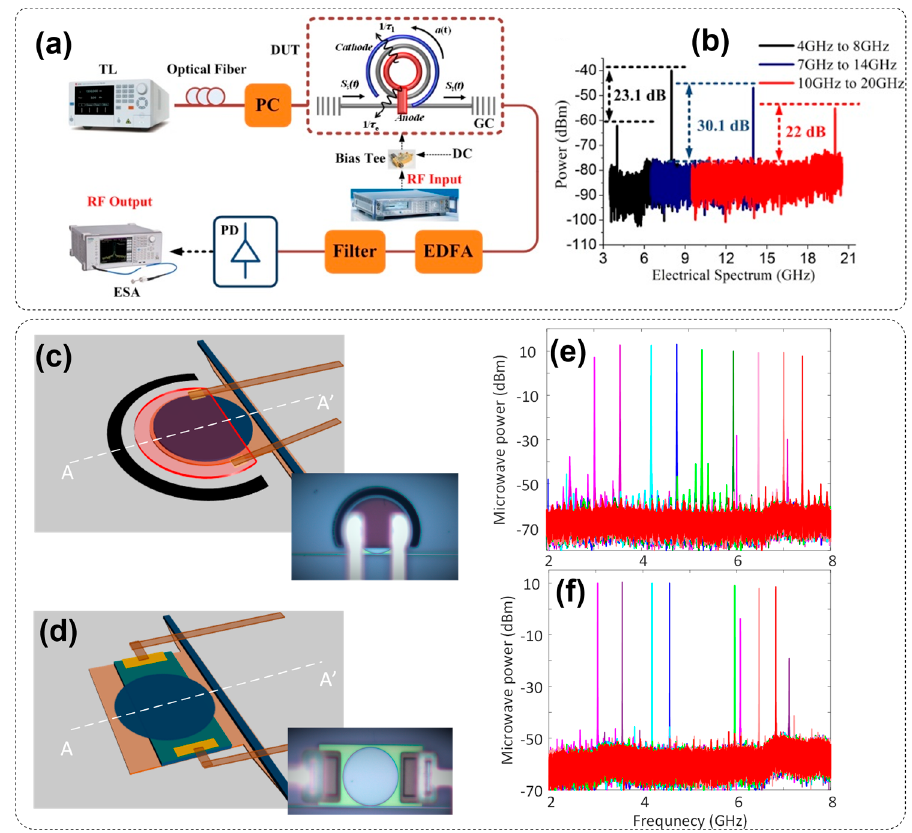
Figure 25. ( a , b ) generation of RF carrier based on a silicon microring modulator reported in